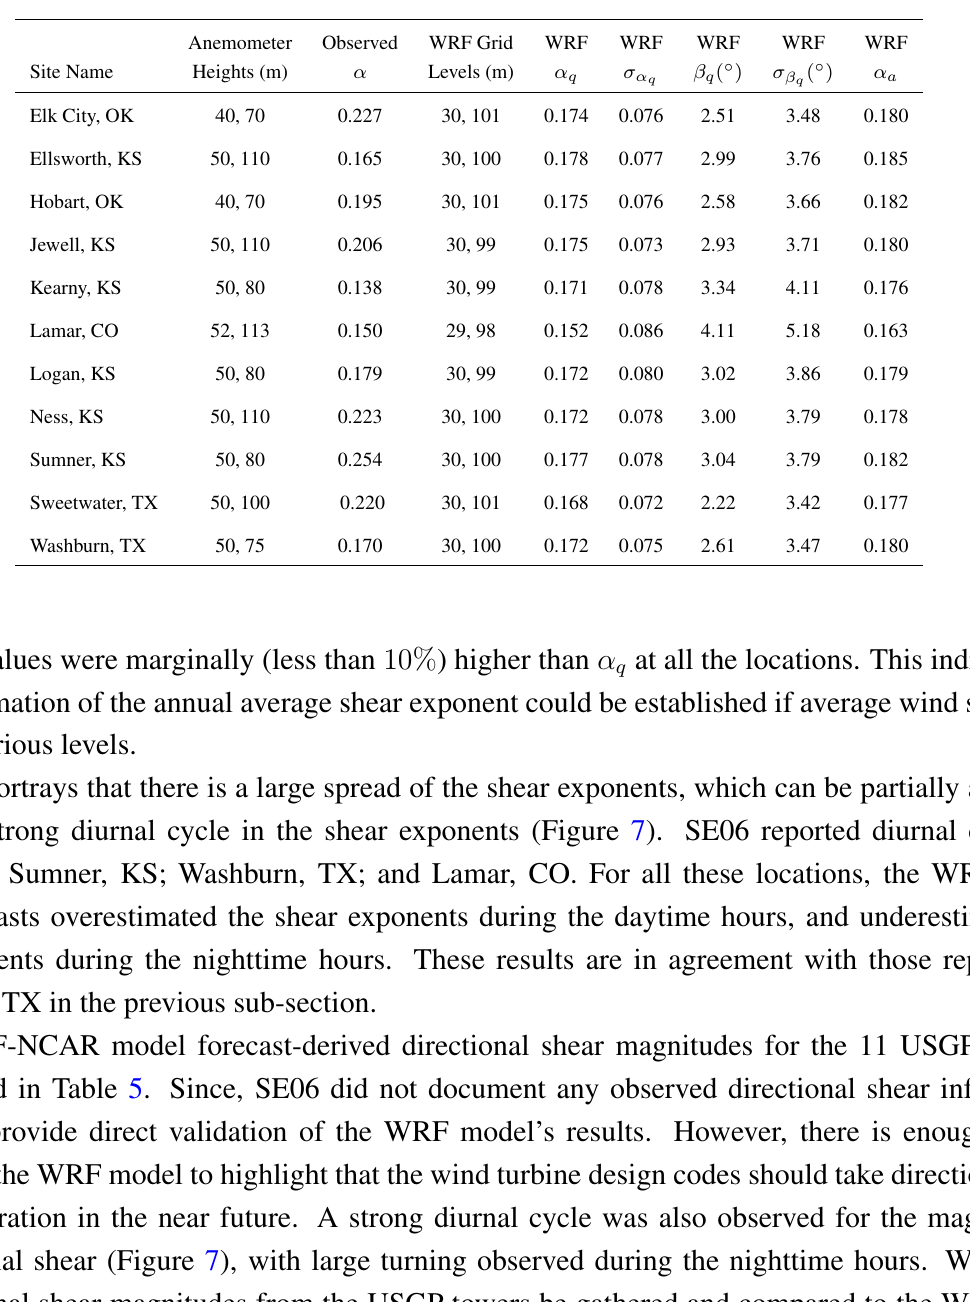
Table 5. Various statistics related to the observed and the WRF-NCAR model forecast-derived average shear exponents and directional shear magnitudes. Study period: varying time periods for the observed data and April 2006–March 2007 for the WRF-NCAR model